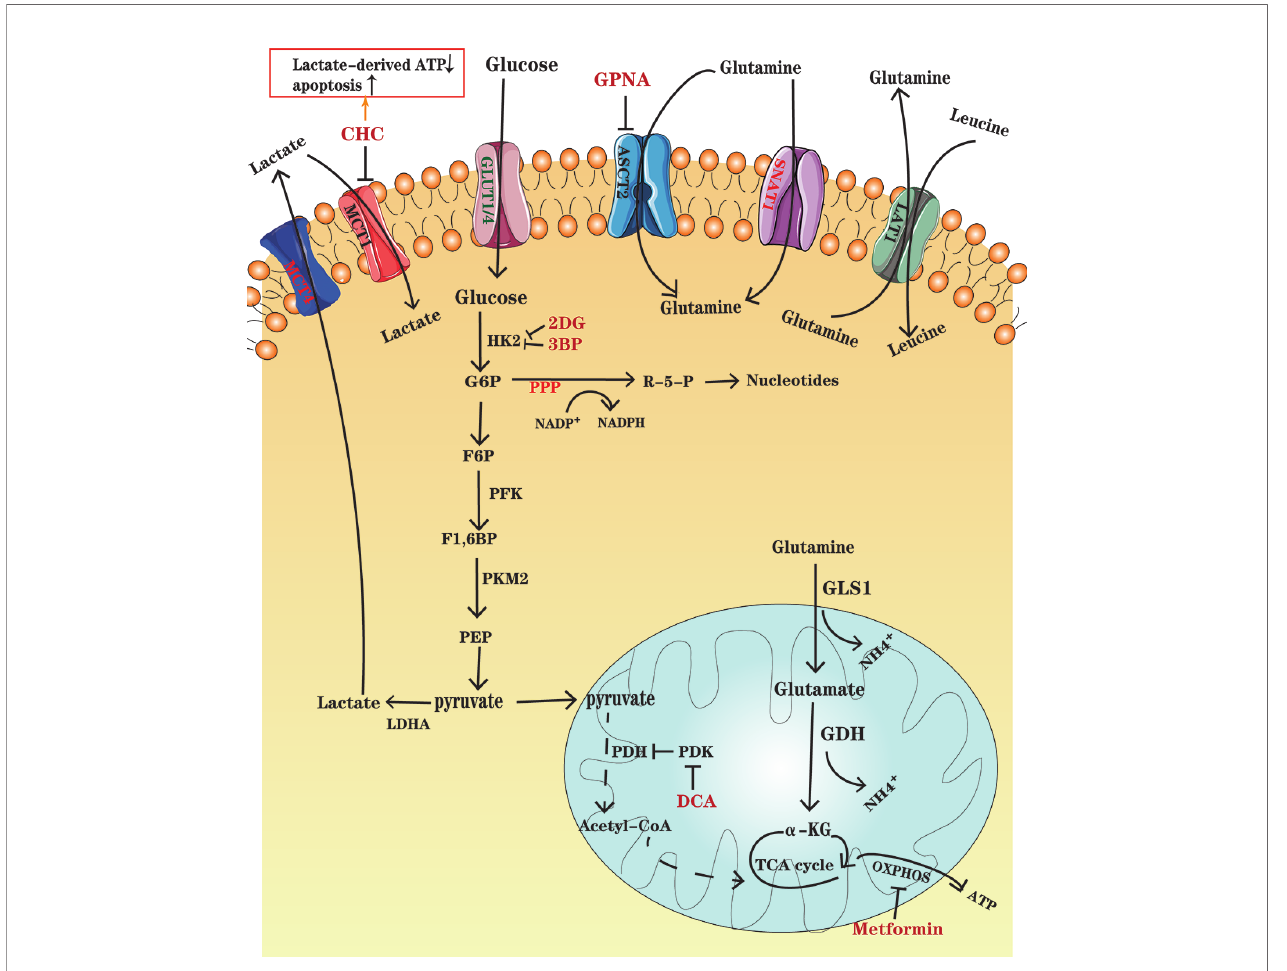
FIGURE 1 | An overview of glucose and glutamine metabolism in MM cells. Glucose enters MM cells through GLUT1 and GLUT4 and is transformed into lactate depending on several key enzymes, including HK2, PFK, PMK2, and LDHA. Lactate is transported out of the cells through MCT4. Some cancer cells in normoxic areas may exploit lactate secreted from hypoxic cancer cells as an energy source and import it into cells by MCT1. PDK, the PDH inhibitor, is overexpressed in MM ells, which results in a decrease in pyruvate entering TCA cycle. Glutamine, as the major substrate for TCA cycle intermediates, enters the MM cells through transporters ASCT2 and SNAT1, in which ASCT2 is the major type. Glutamine can be exported out of the cell through antiporters LAT1 in exchange for other amino acids such as leucine. Glutamine is converted to glutamate by the enzyme GLS and further to a-KG by GDH, which fuel the TCA cycle. Drugs, such as CHC, GPNA, 2DG and so on, have been designed to inhibit the important enzymes and transporters and thus to disturb metabolism in MM cells. Further details are found in the main body of